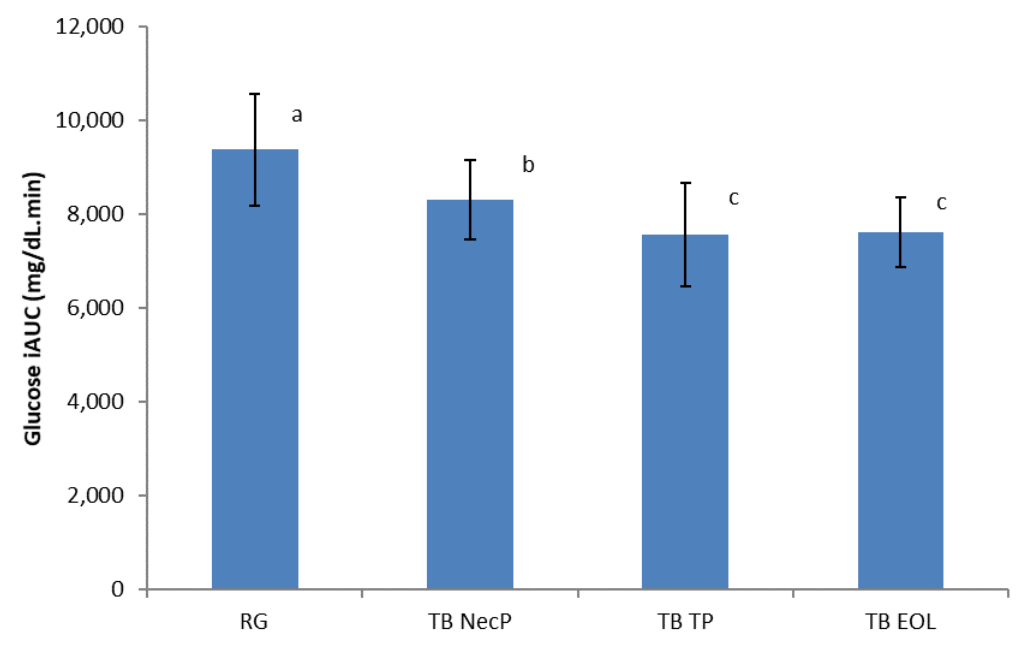
Figure 3. Incremental area under the curve (iAUC) postprandial glucose responses for the three treatment beverages. TB NecP (2 g of NecP, equivalent to 14 µg ABA), TB EOL (400 mg EOL,